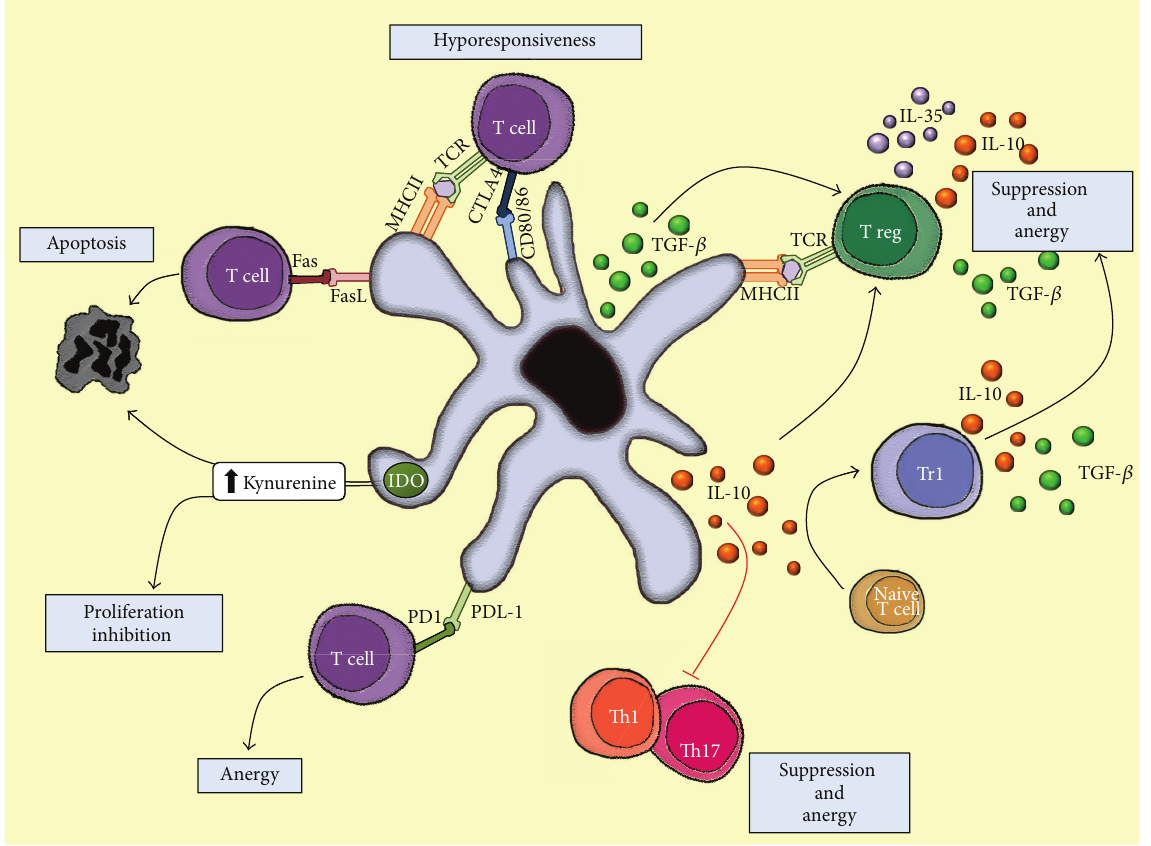
Figure 1: Summary of different mechanisms to induce tolerance by DCs; Treg and Tr1 cells generation, suppression of T effector cells, inhibition of proliferation, apoptosis induction, T cell anergy, and